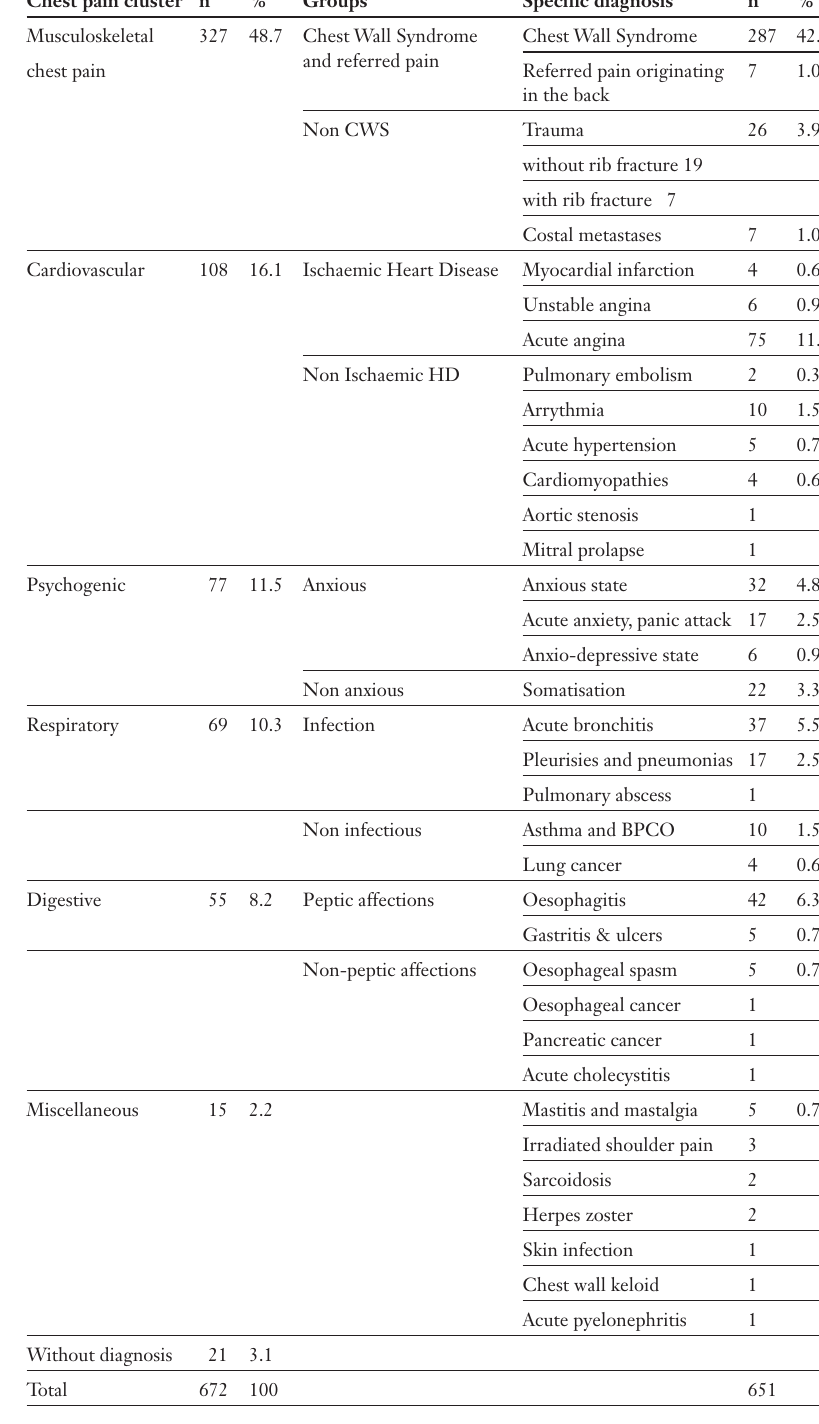
Proposed aetiologies of chest pain in 672 patients present- ing with chest pain to a primary care